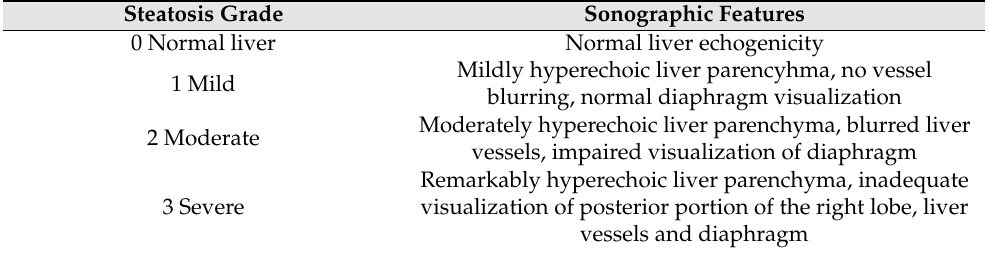
Table 2. The grading of HS depending on the sonographic features